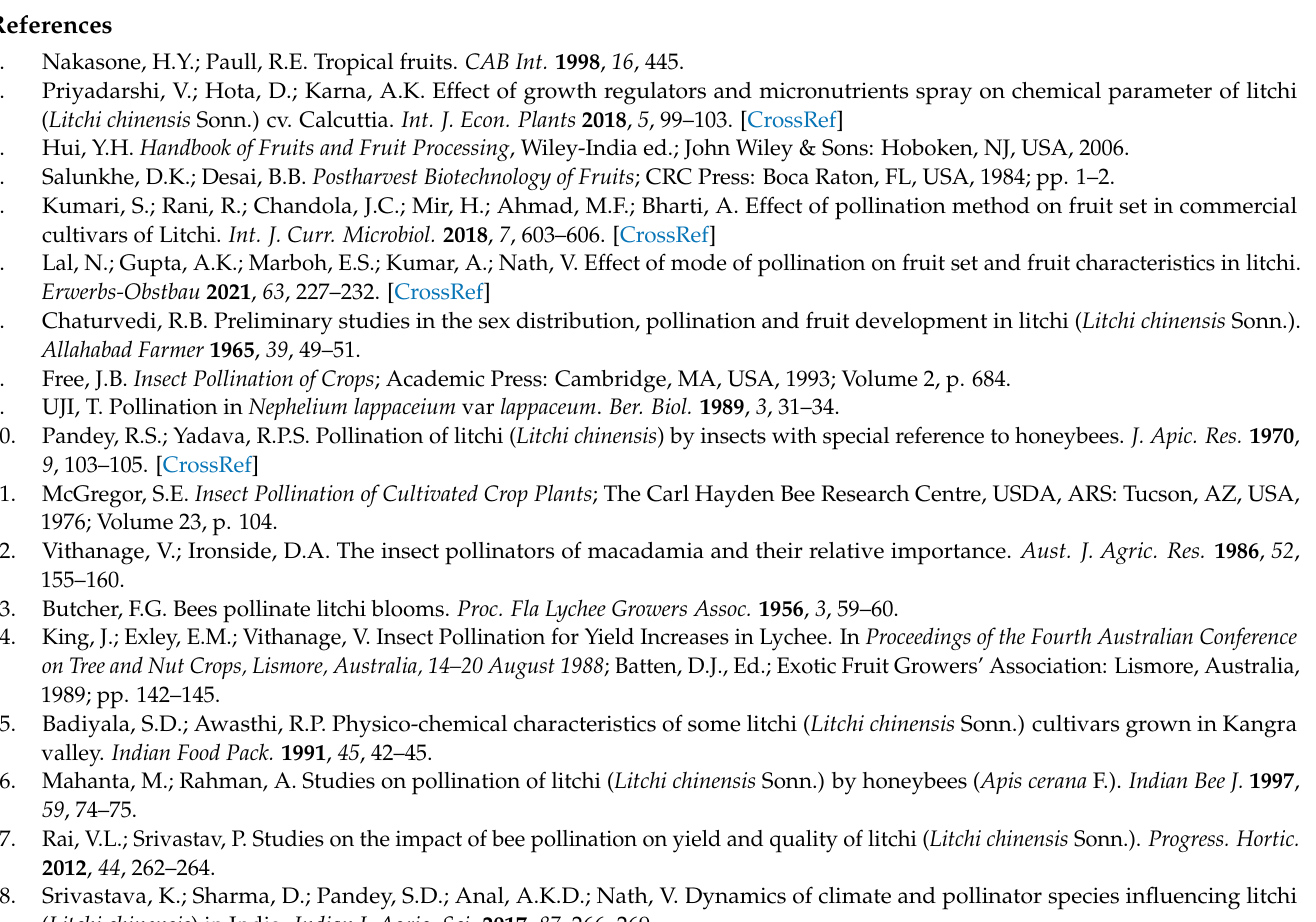
Table S3: Effect of varied mode of pollination on litchi